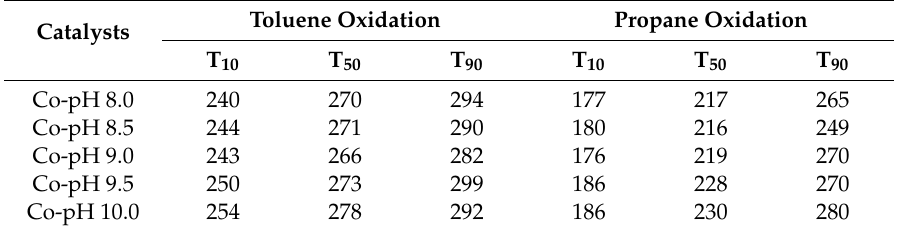
Figure 5. ( A ) Toluene and ( B ) propane oxidation over cobalt oxides prepared at different pH values. Table 2. Temperature values of 10% (T 10 ), 50% (T 50 ) and 90% (T 90 ) toluene and propane conversion of cobalt oxides prepared at different pH values.